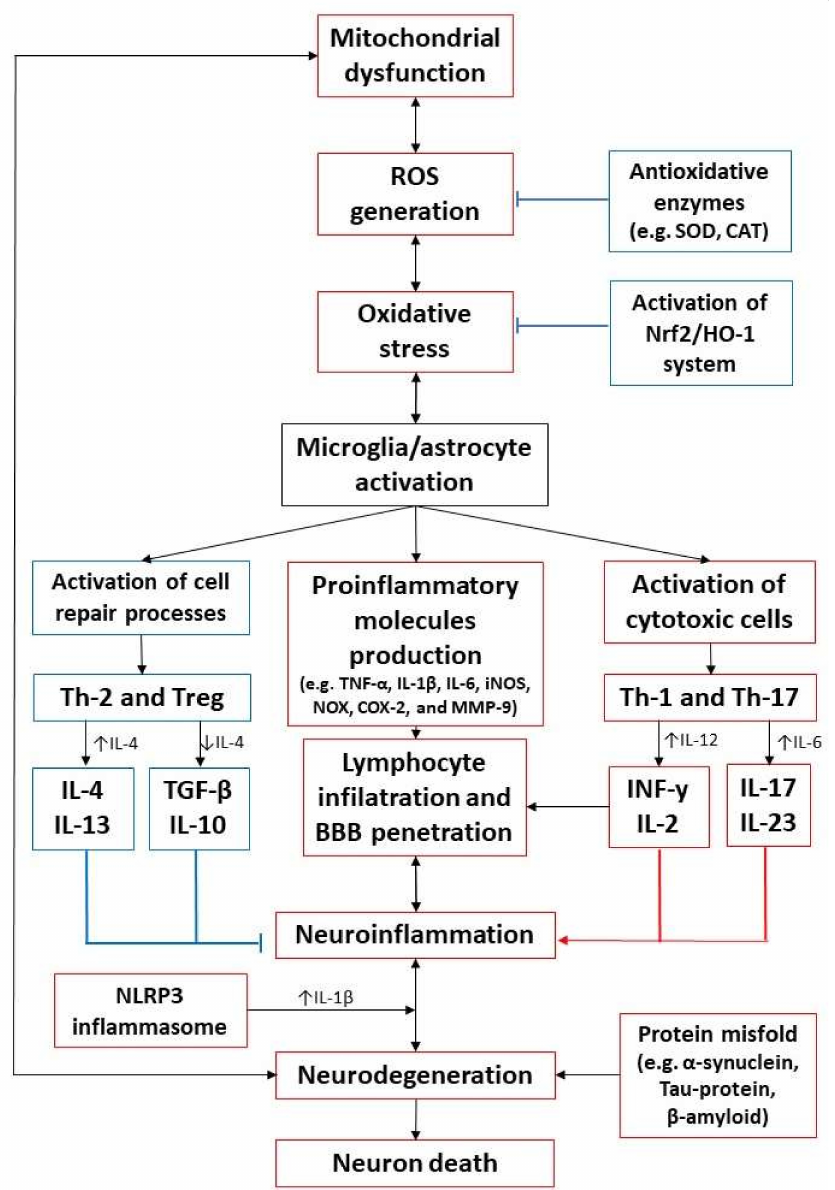
Figure 1. Oxidative and inflammation pathways in neurodegeneration. Increased ROS production caused, inter alia, by mitochondrial dysfunction, generating oxidative stress, is a direct reason for neuroinflammation and neurodegeneration. ROS stimulates altered intracellular signaling leading to microglia and astrocyte activation, characterized by a dual response depending on the activation